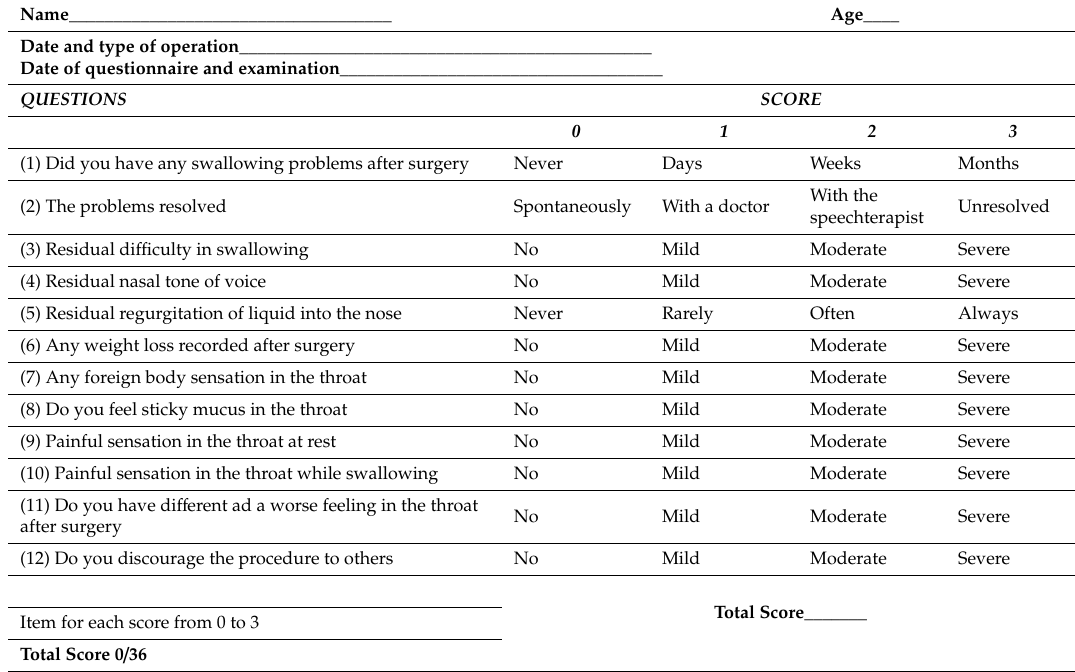
Table 1. Palate Postoperative Problem Score (PPOPS)